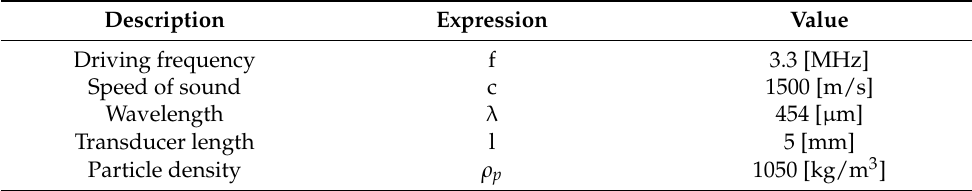
Table 2. Simulation parameters related to the SAW study.